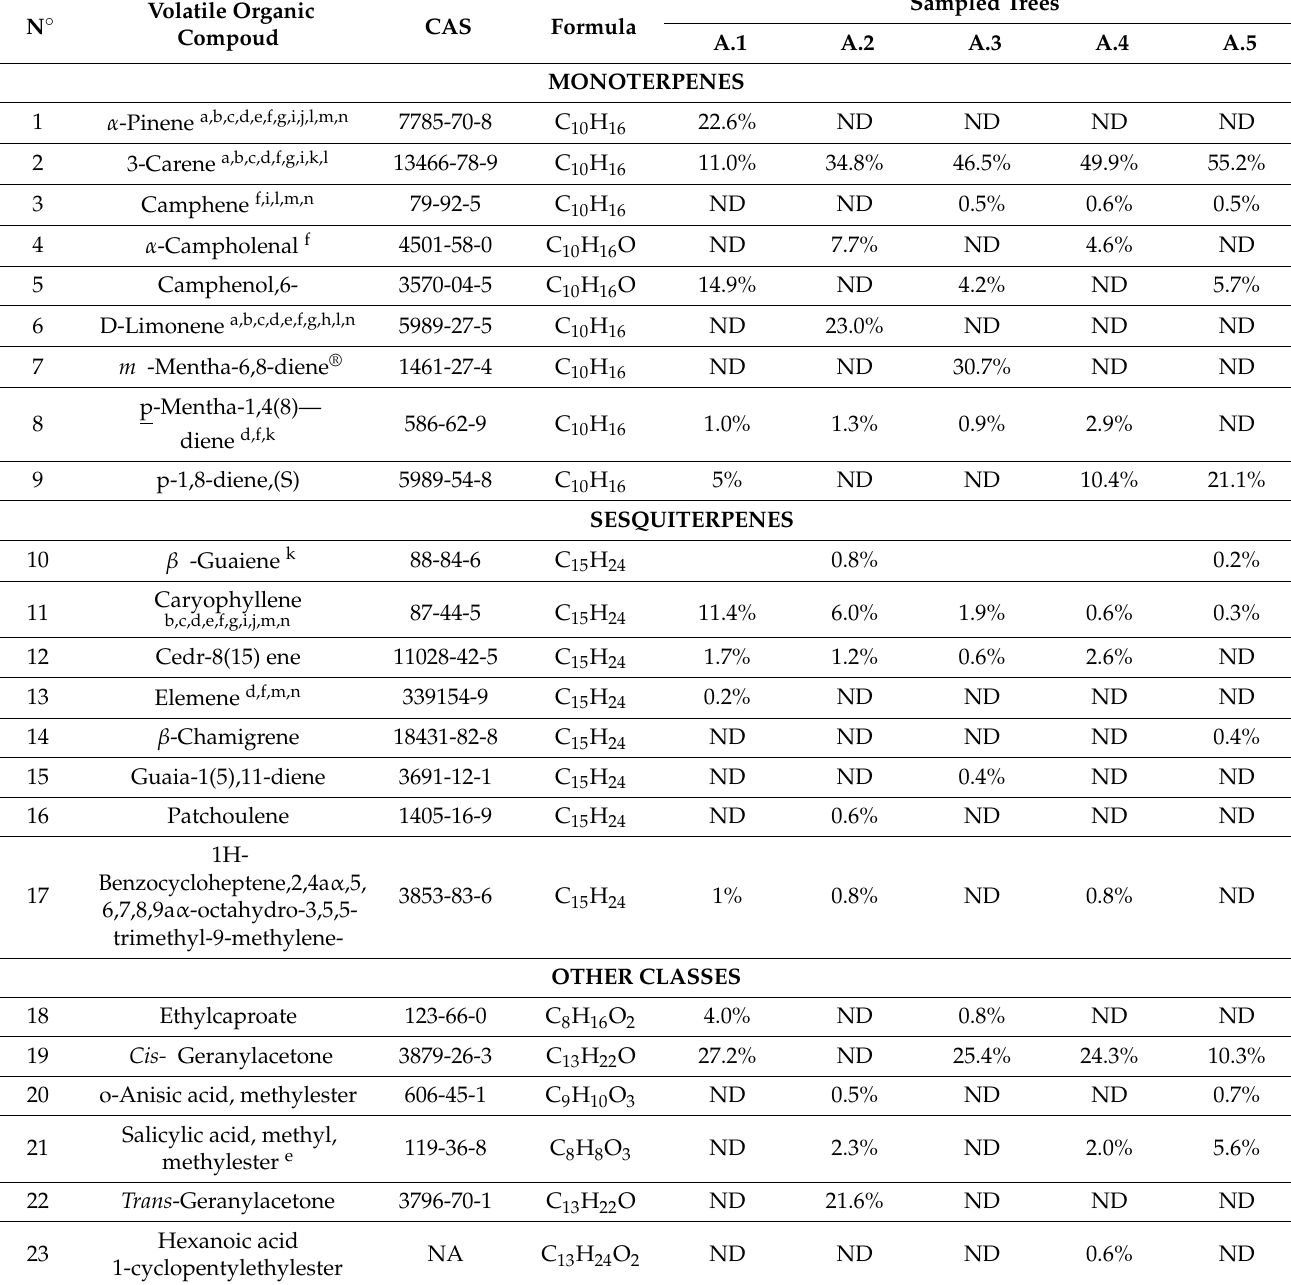
Identified Volatile compounds: letters indicate compounds found by other authors in different species of the Anarcadiceae